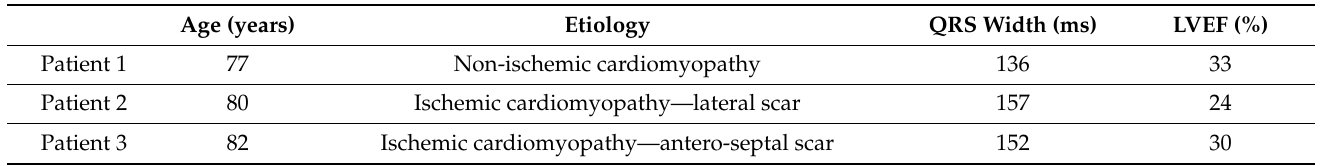
Table 1. Main patient